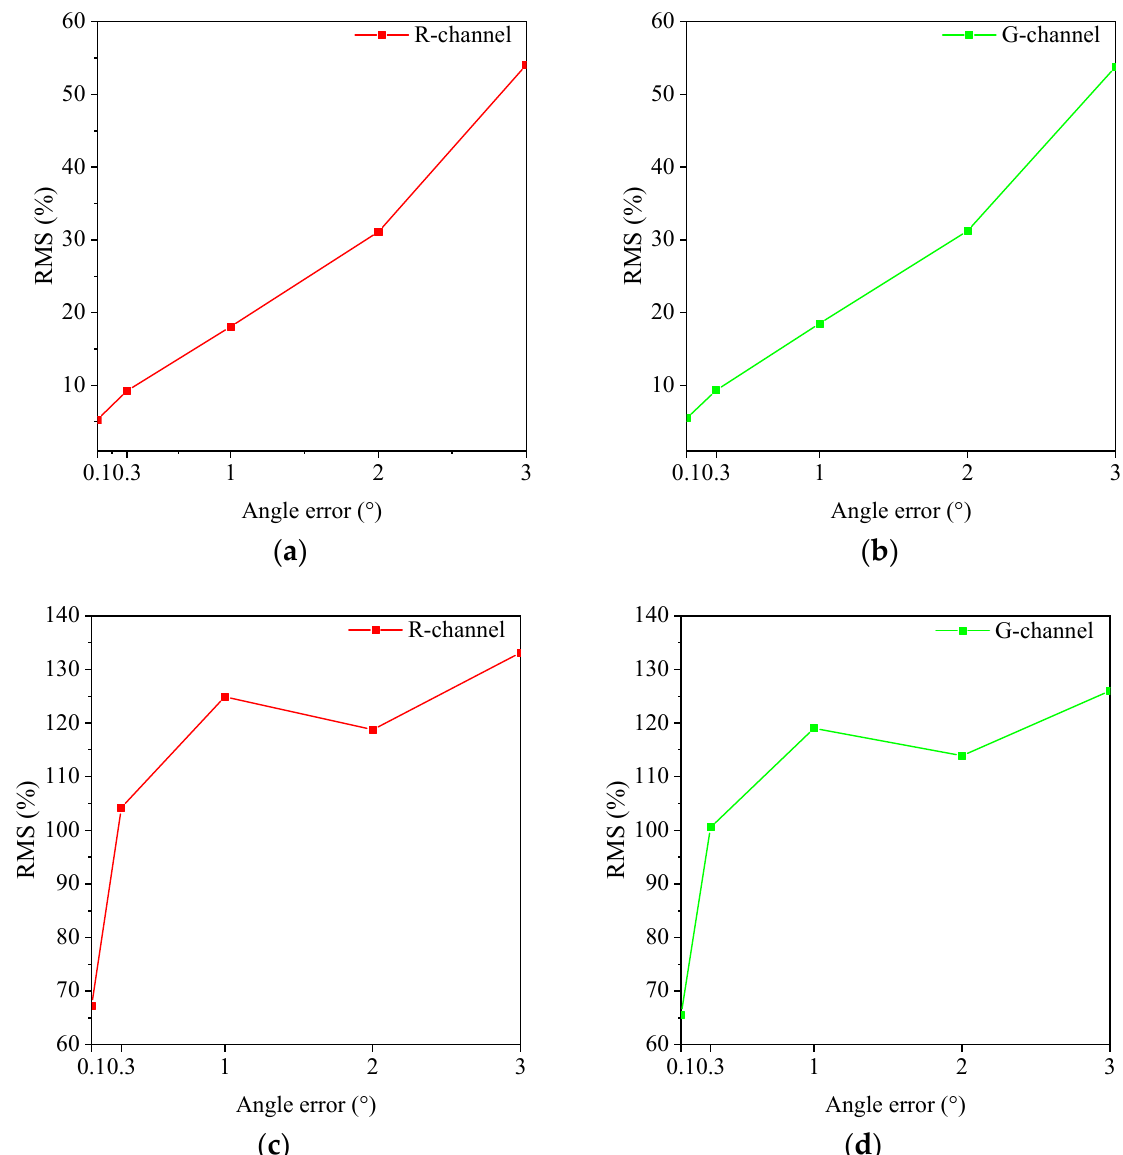
Figure 12. Influence of different interval-angle errors on the reconstruction accuracy of the two algorithms: influence on the regularization algorithms of channel R ( a ) and channel G ( b ) and influence on the LSQR algorithms of channel R ( c ) and channel G ( d ).